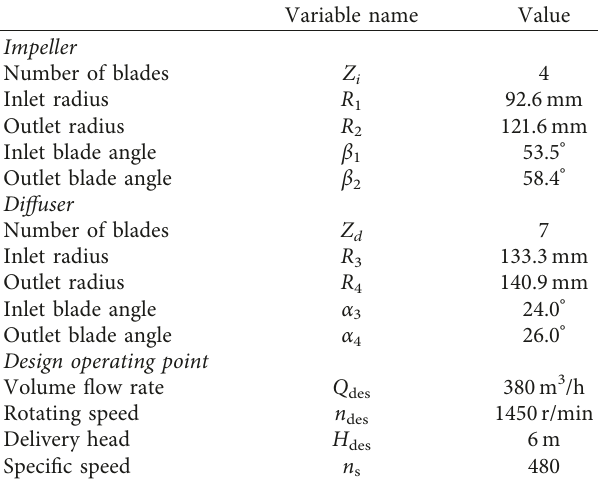
Figure 1: Mixed-flow pump model. (a) Impeller of mixed-flow pump. (b) Transparent chamber of mixed-flow pump. Table 1: Specifications of the investigated